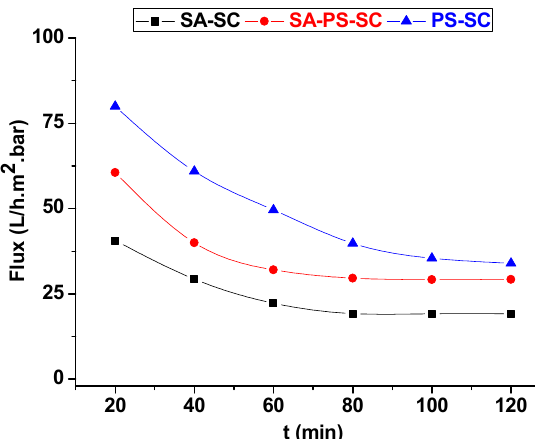
Figure 12. Permeate of textile effluent versus filtration time.